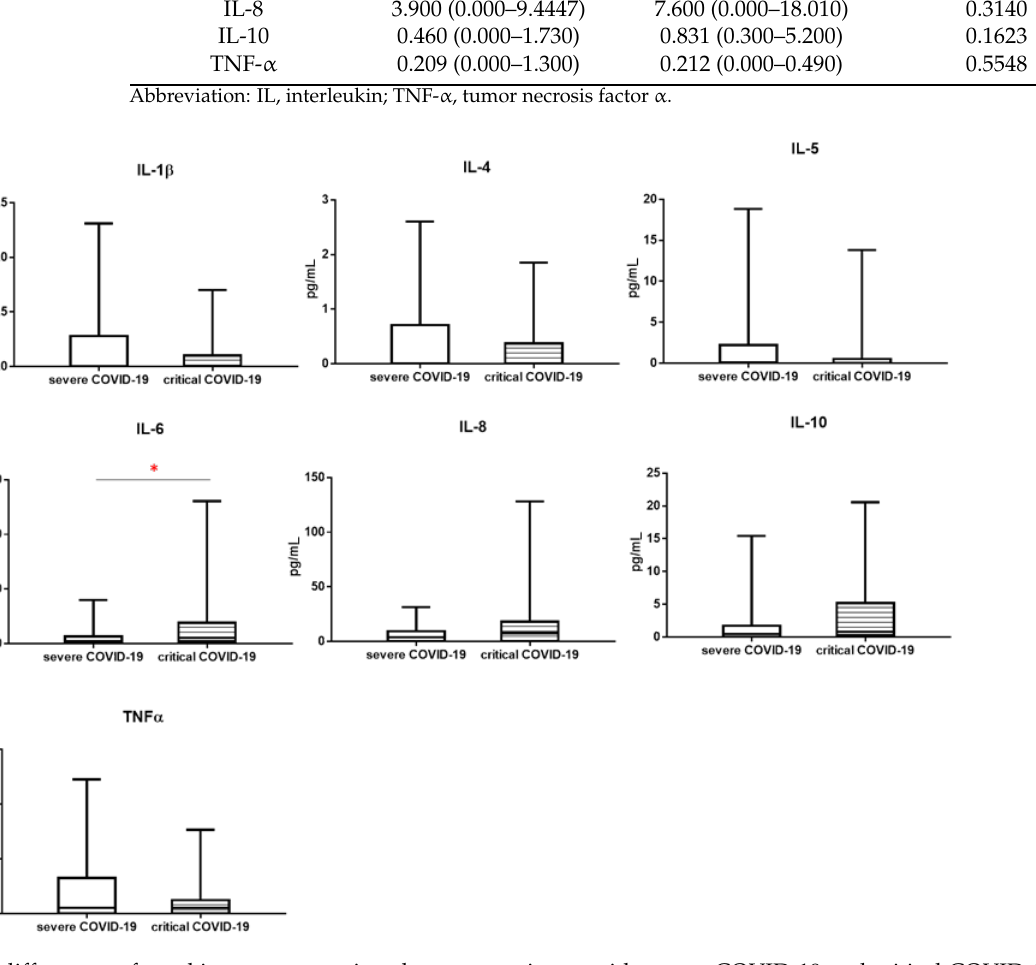
Figure 3. The differences of cytokines concentrations between patients: with severe COVID-19 and critical COVID-19. Graphs show the median values (Min–Max), * p <